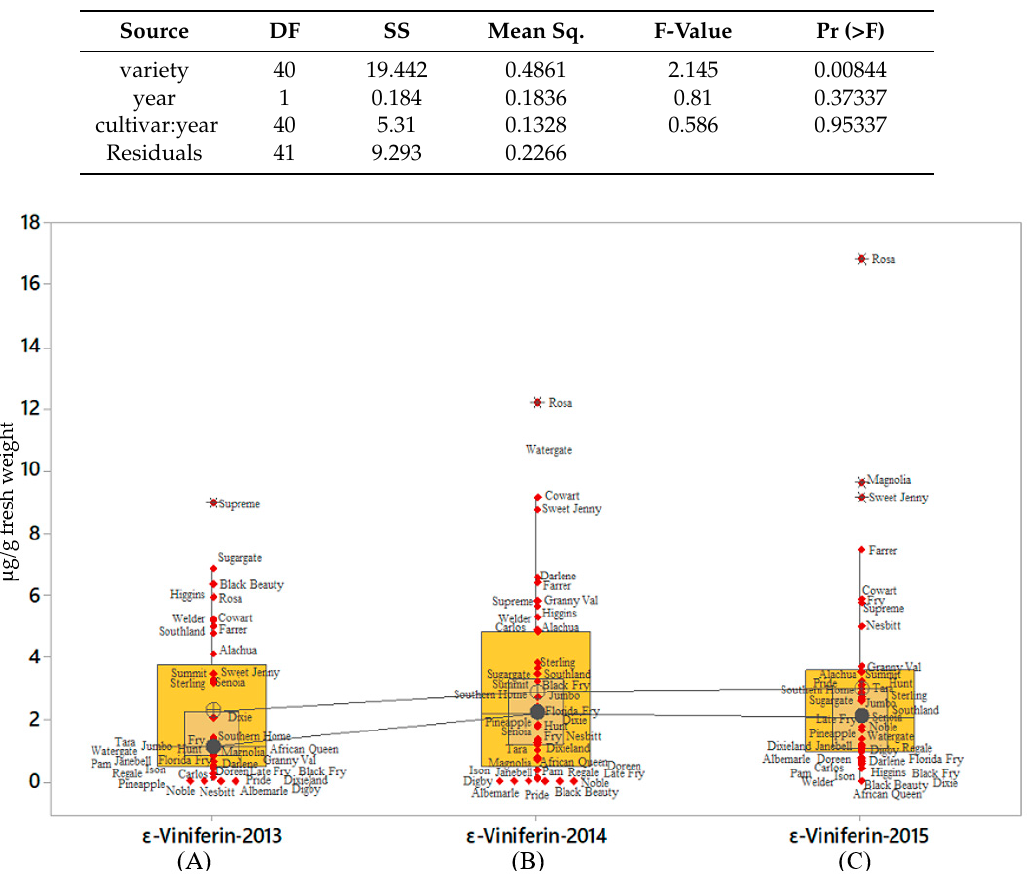
ε -viniferin present in various muscadine cultivars. The ε -viniferin accumulation Figure 4. Levels of ε‐ viniferin present in various muscadine cultivars. The ε‐ viniferin accumulation in Figure 4. Levels of